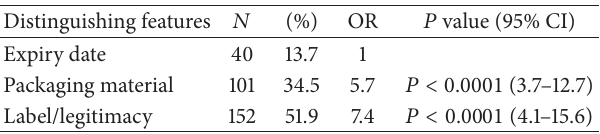
Table 6: Association of distinguishing features and identification of genuine and counterfeit